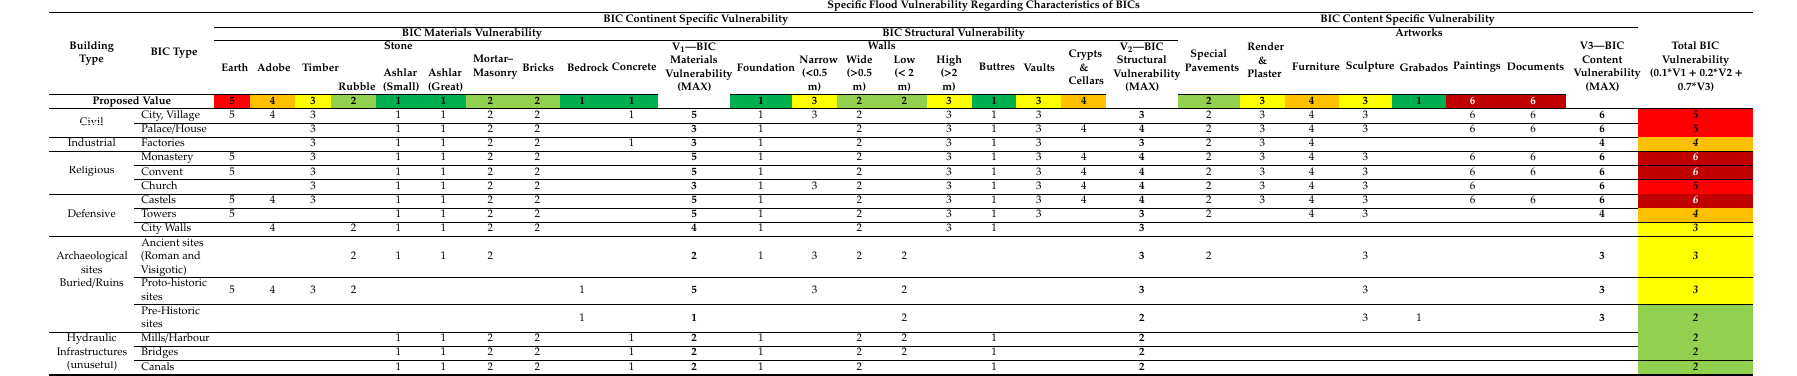
Table 2. Flood vulnerability matrix for cultural heritage